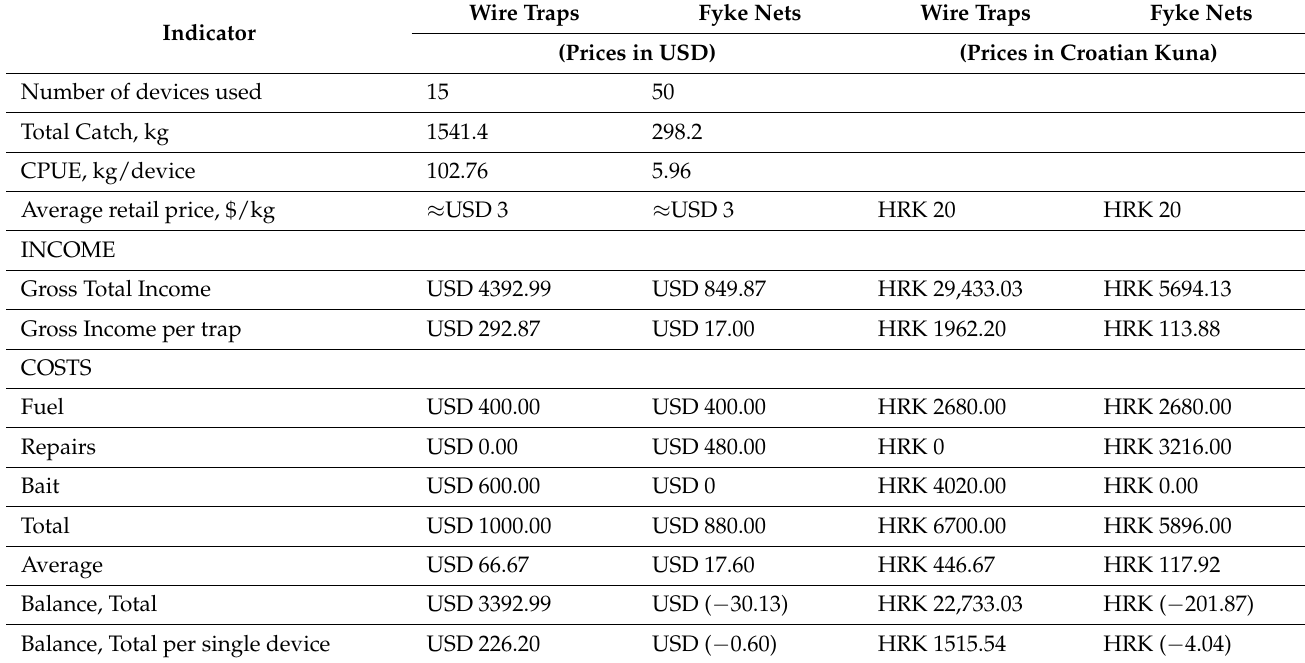
Table 1. Results on the fishery, economic, and financial performance of American wire traps and fyke nets in Parila lagoon during the crabbing season from July to December 2019 (currency exchange rate: 1 USD = 6.7 HRK; June–December